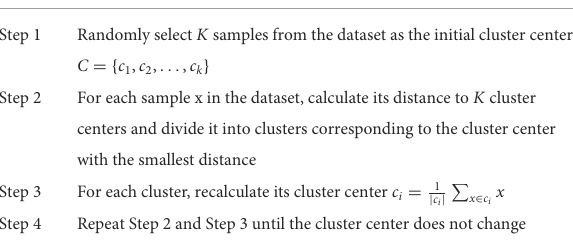
TABLE 1 k- means